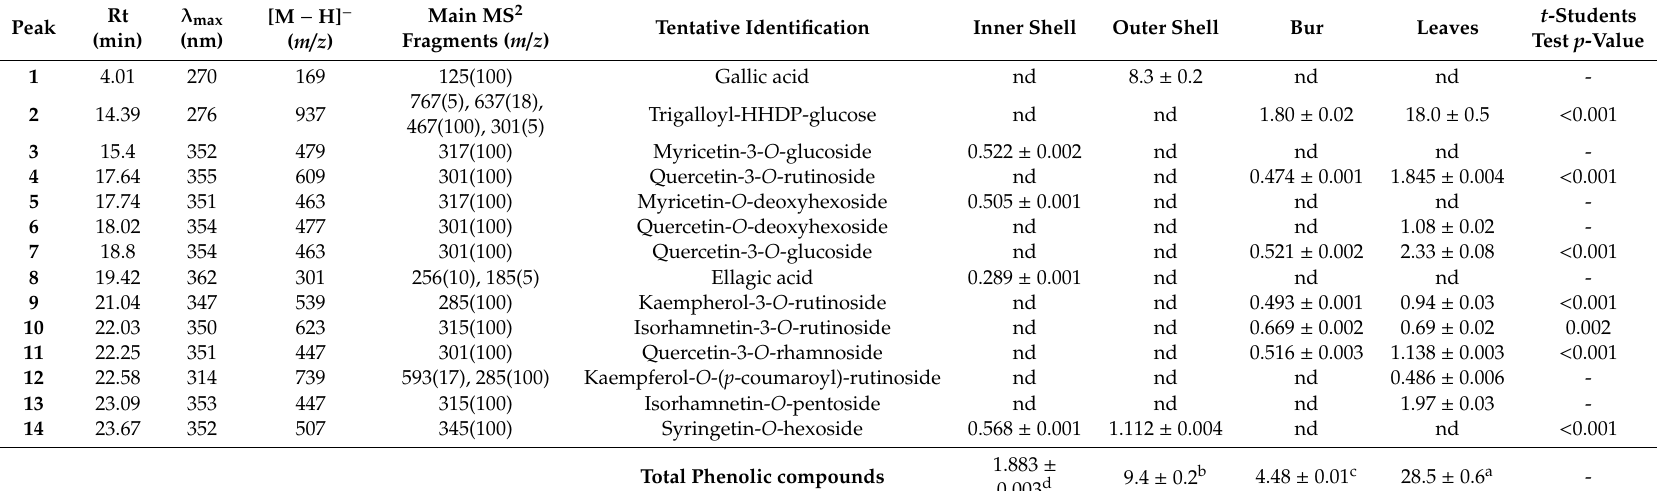
Table 2. Retention time (Rt), wavelengths of maximum absorption in the visible region ( λ max ), mass spectrometric data, tentative identification, and quantification (mg / g extract) of the phenolic compounds present in the ethanolic extracts of chestnut inner and outer shells, bur, and leaves.